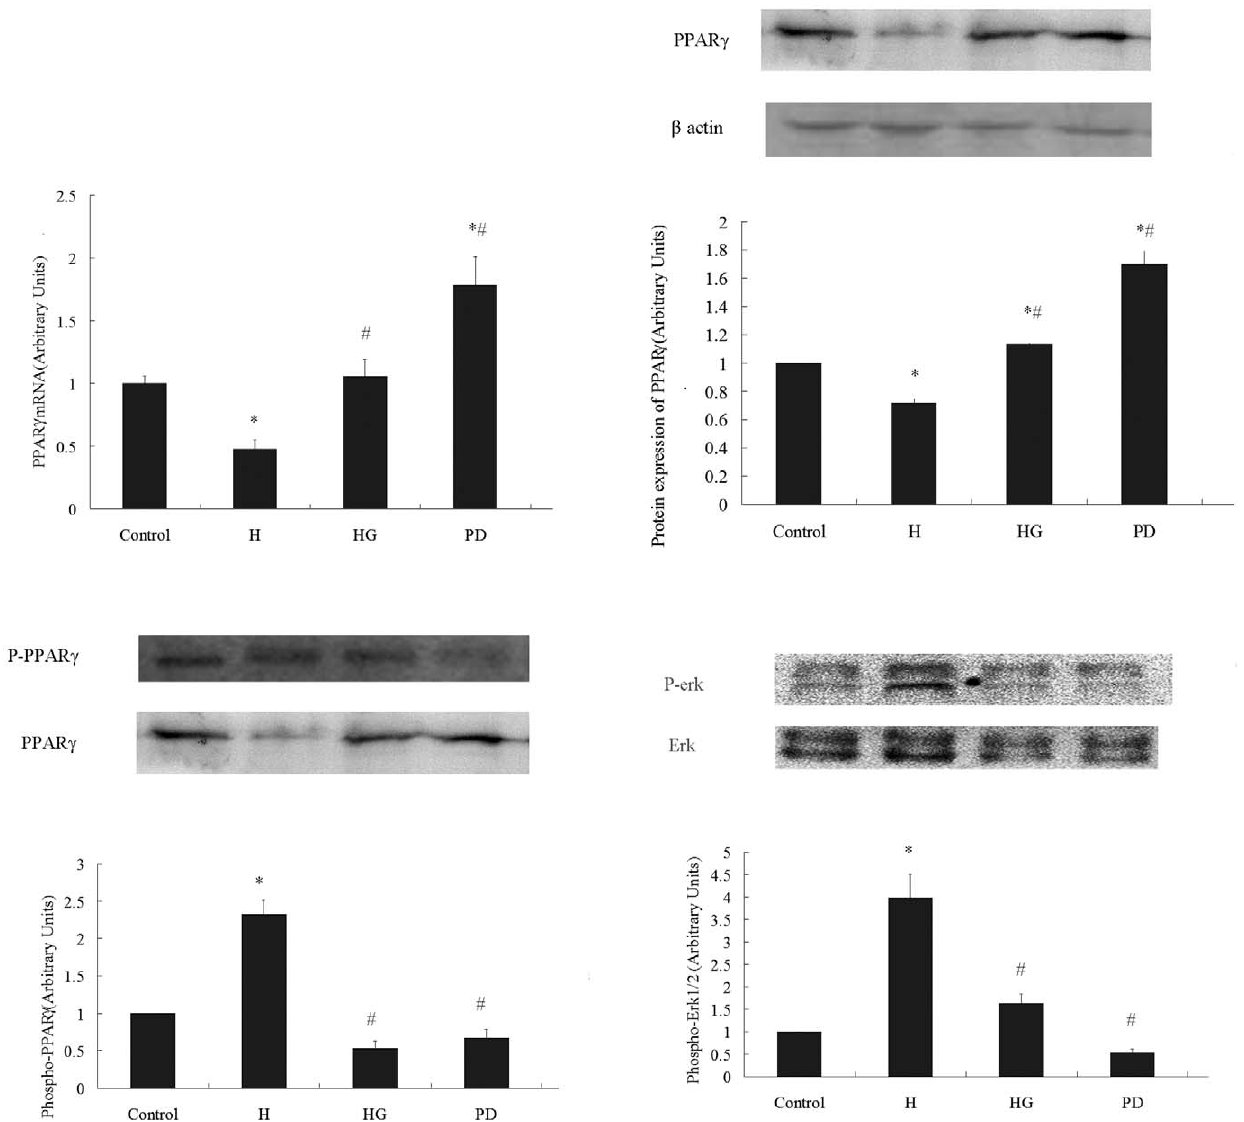
Figure 5. Inhibition of erk1/2 and GTPs treatment attenuated the phosphorylation and down-expression of PPAR c and erk1/2 activation in cultured VAT under high glucose condition. The cultured VAT explants were treated with GTPs and PD98059, respectively. High glucose incubation down-regulated the PPAR c mRNA (A, N=6) and protein expression (B, N=3) while up-regulated the phosphorylation of PPAR c (C, N=3) and phosphorylation of erk1/2 (D, N=3), all the above effects could be attenuated by GTPs or PD98059. (*P , 0.05 vs. the control; # P , 0.05 vs. the HG group). Data is expressed as Mean 6 SEM.